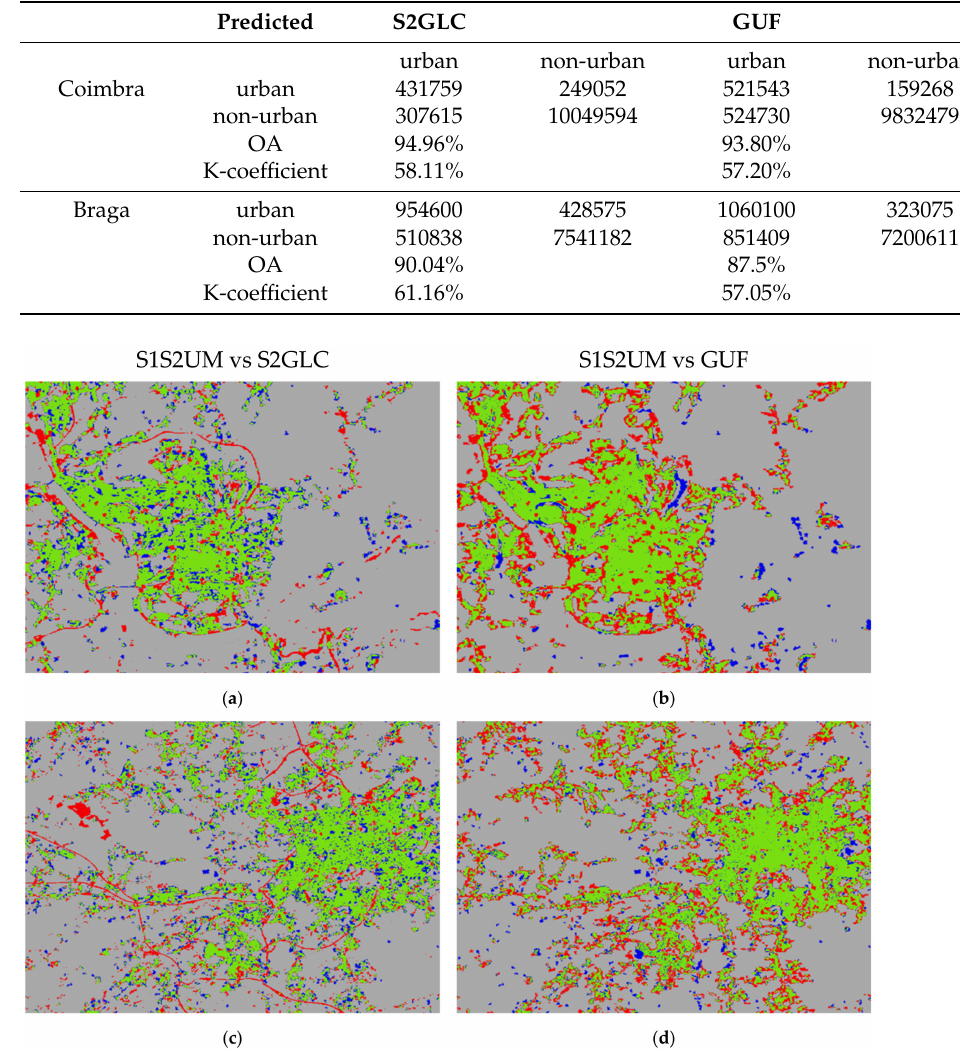
Figure 13. Comparison with state-of-the-art techniques for Coimbra ( a , b ) and Braga ( c , d ). Green: pixels detected as urban by S1S2UM and the reference methods, S2GLC ( a , c ) and GUF ( b , d ). Blue: pixels detected only by S1S2UM. Red: pixels detected only by the reference